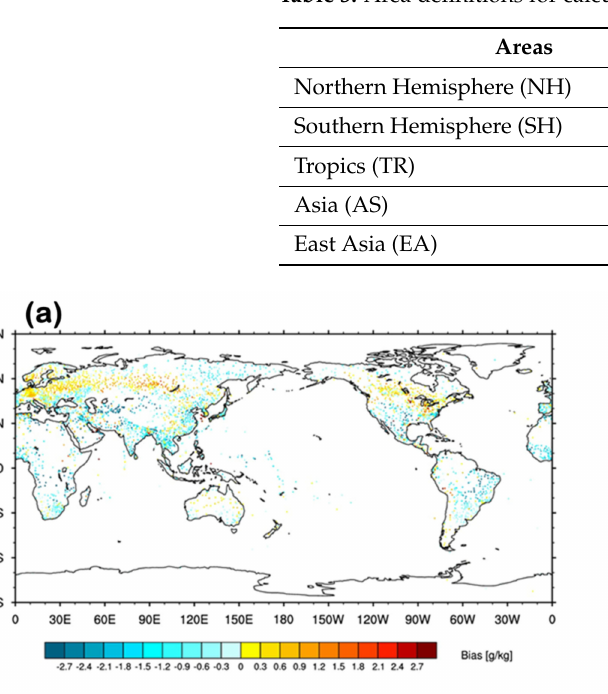
Table 3. Area definitions for calculating the scorecards (Figure 12).